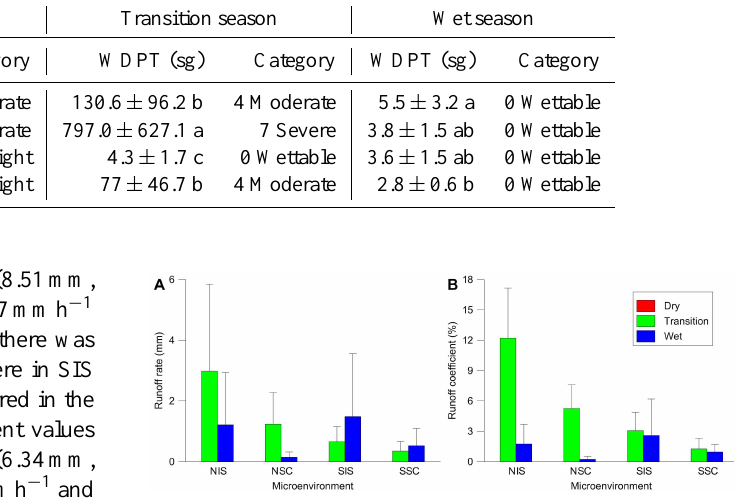
Fig. 3. Mean values of runoff rate and coefficient for every mi- croenvironment and season. Error bars represent standard deviation. NIS: north-facing inter-shrub; NSC: north-facing shrub-covered; SIS: south-facing inter-shrub; SSC: south-facing shrub-covered. No runoff was found in the dry